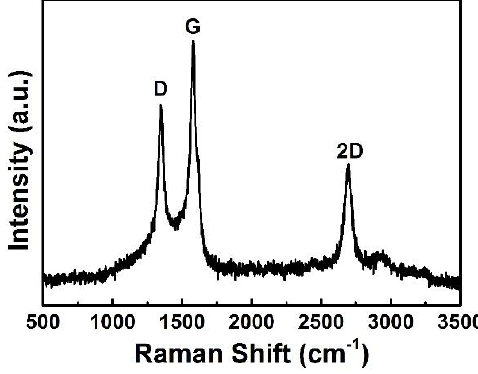
Figure 2. Raman spectrum of the C@Fe 2 O 3 composite.